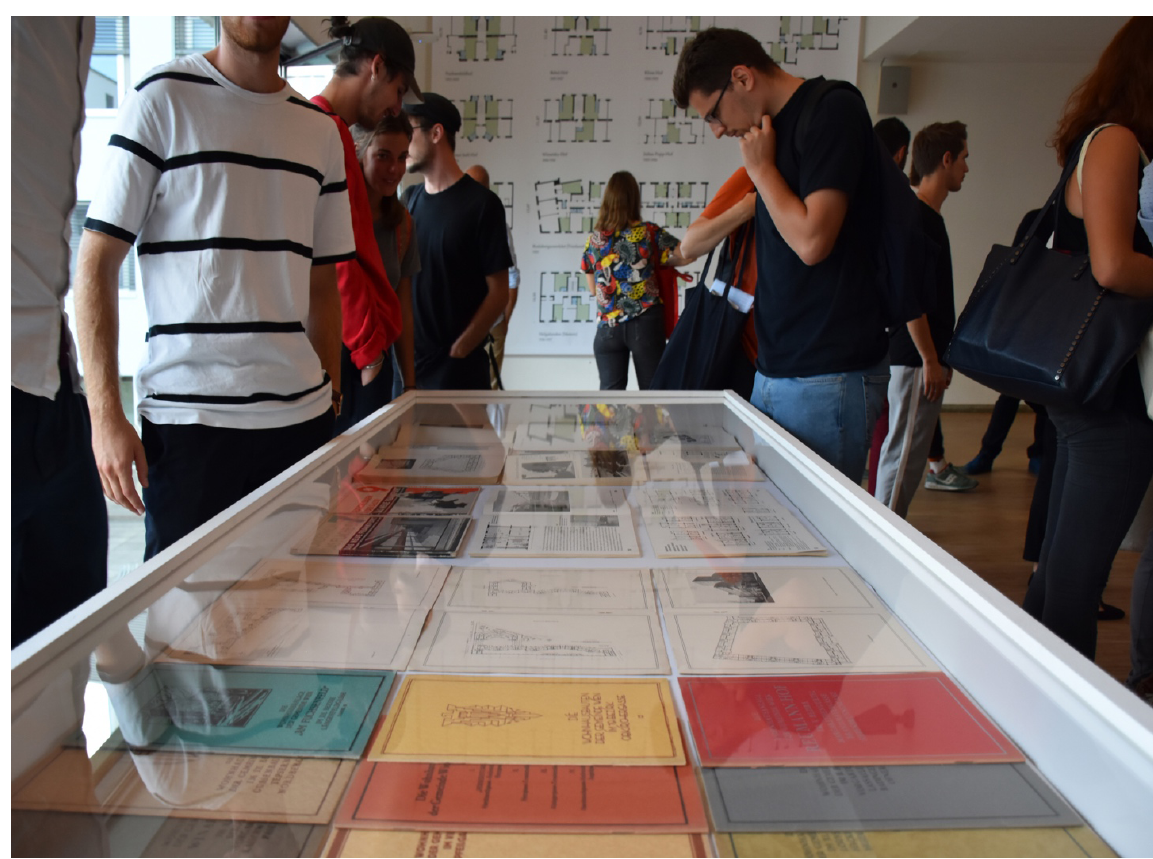
Figure 6. The showcase contains original books and journals. Source: Authors. mediary concern between the two models. In the exhi- bition, more attention was paid to those experimenta- tions in the large courtyard block model, the well-known storgårdskvarteret